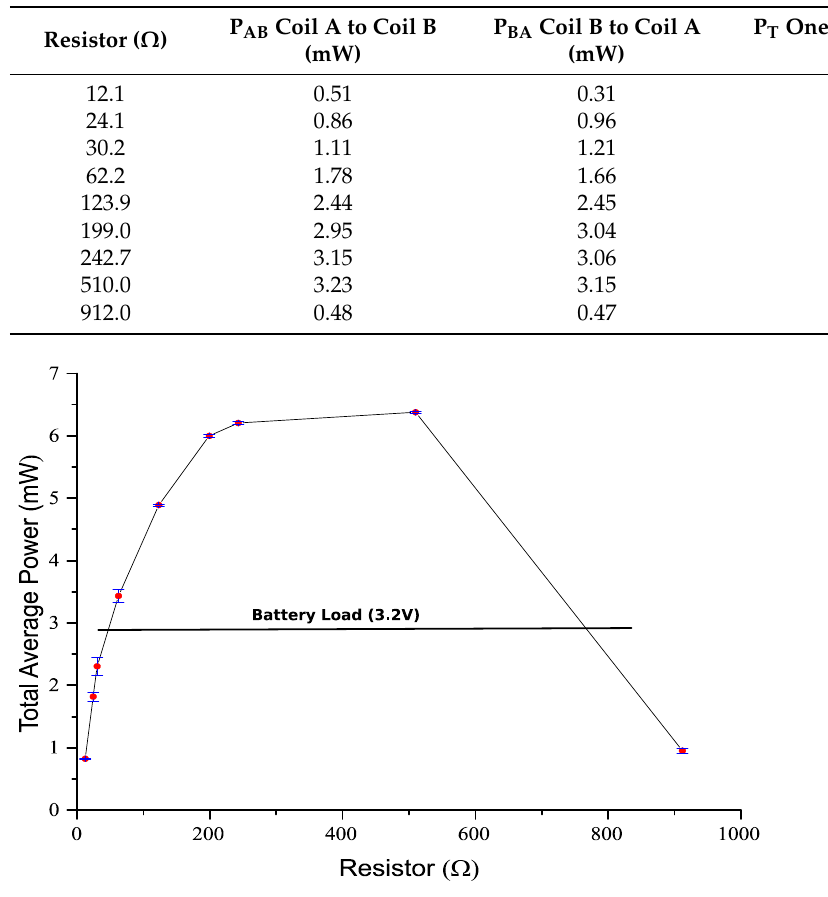
Figure 12. Load dependence of average power in freefall test. The line represents a constant voltage load of 3.2 V, equivalent to a lithium rechargeable battery. Mean values (dots) and mean ± standard deviation.